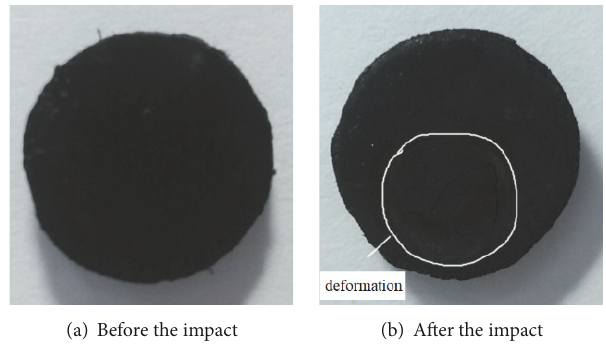
Figure 16: High-damping rubber samples before and after impact.